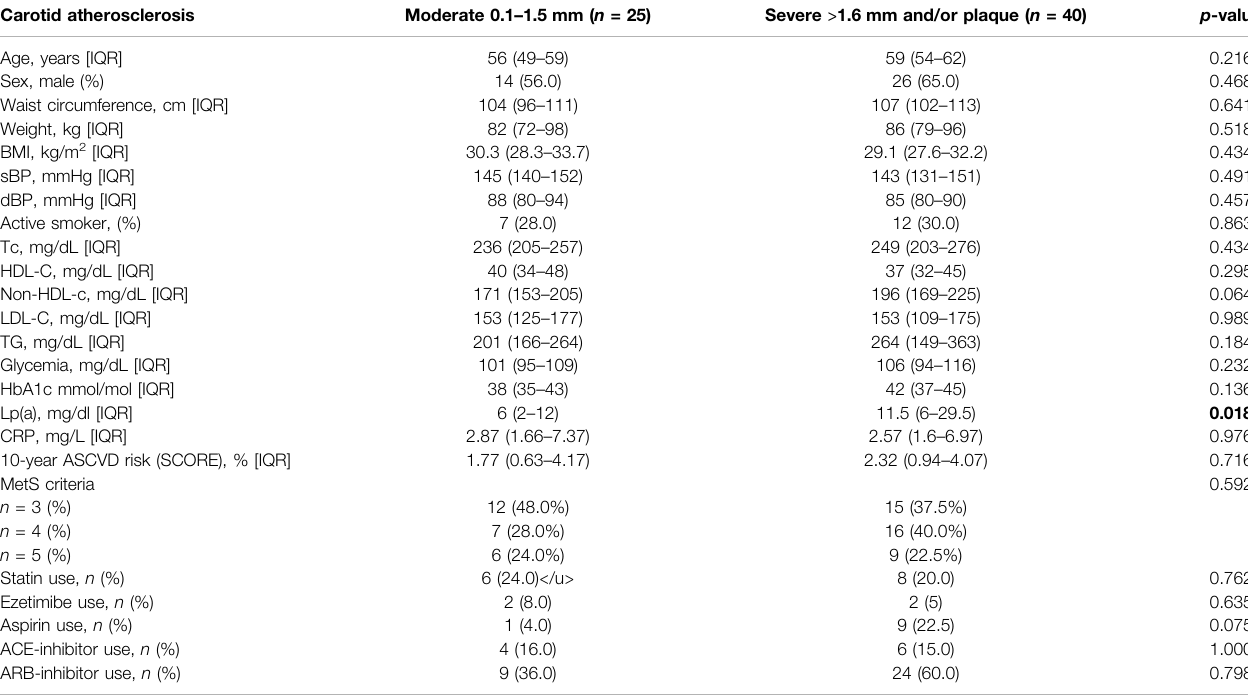
TABLE 2 | Characteristics of 65 patients with metabolic syndrome divided according to the severity of carotid atherosclerosis identi fi ed with the echo-color Doppler study. Carotid